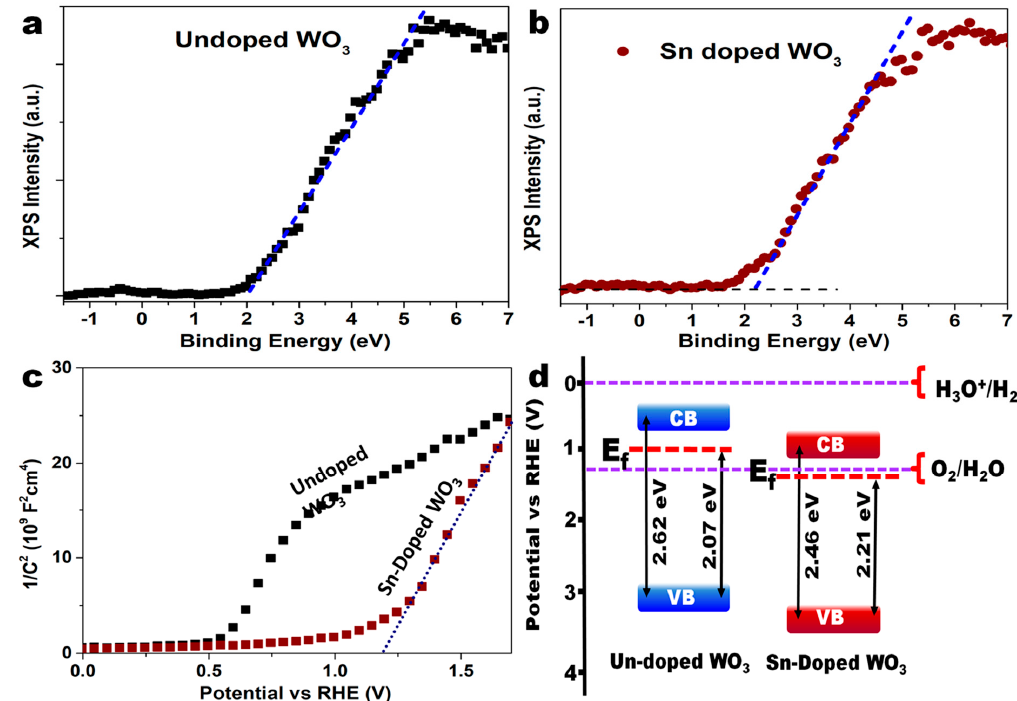
Figure 7. XPS valence band edge plot of ( a ) undoped and ( b ) Sn-doped WO 3 thin films. ( c ) Mott–Schottky plot of undoped and Sn-doped WO 3 thin films. ( d ) Band edge position of WO 3 plotted against RHE before and after doping with Sn.